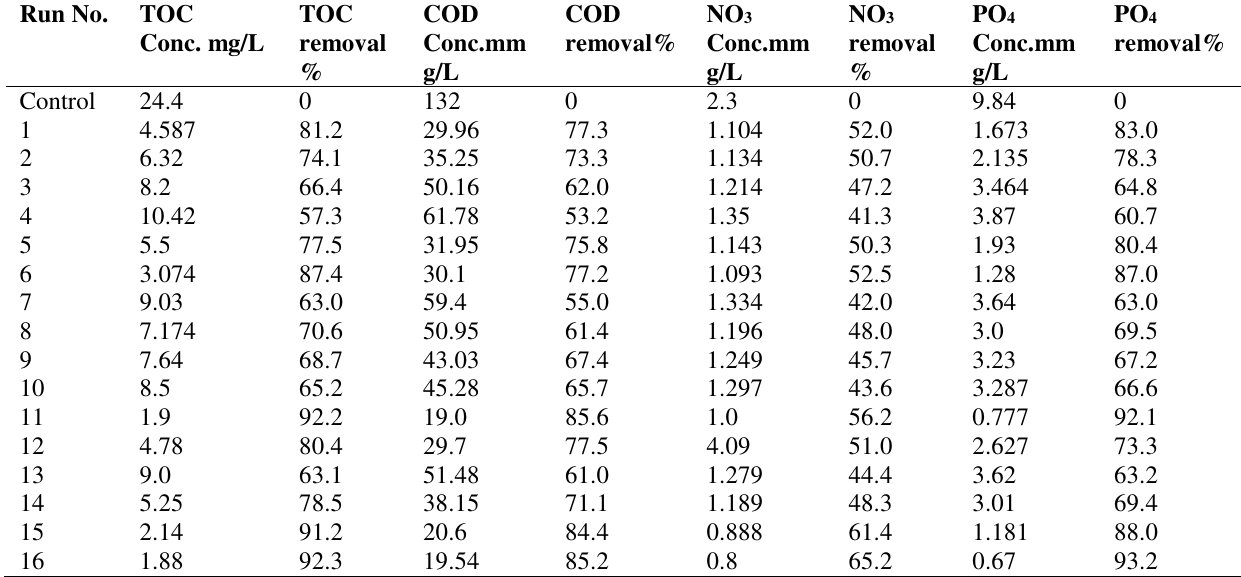
Table 3, Effect of parameters of table 2 on the concentration of pollutants and their removal per cent for sterilized wastewater using broth of microalgae and treatment time of 48 hours. Run No.